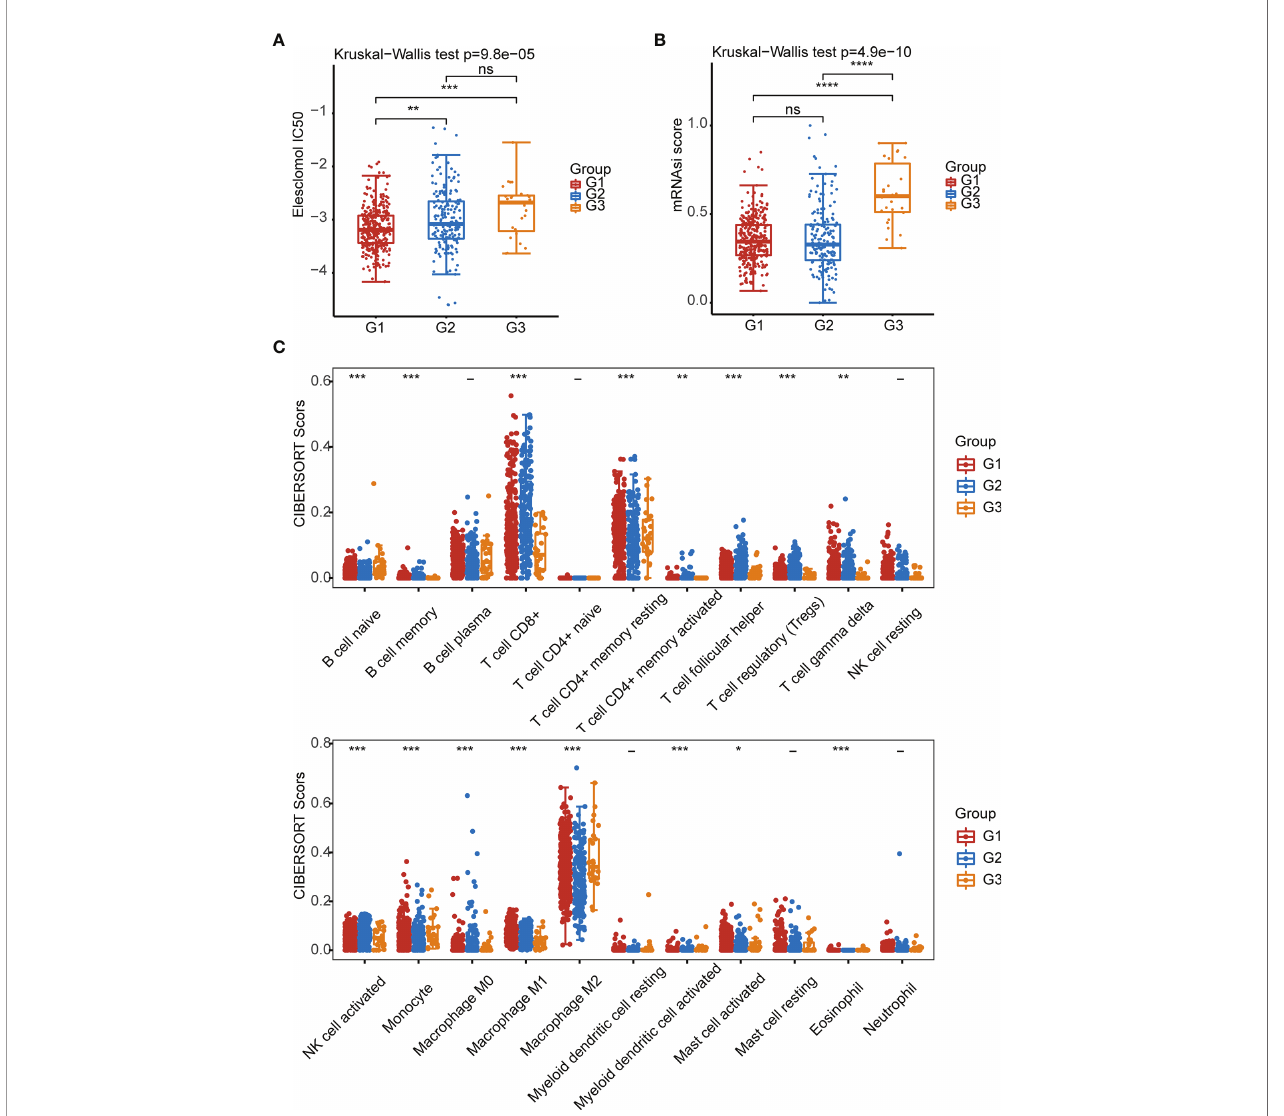
FIGURE 3 | Elesclomol sensitivity, tumor stemness and immune in fi ltration characteristics in the three subtypes of KIRC. (A) IC50 values of elesclomol. (B) Tumor stemness scores. (C) Abundances of 22 in fi ltrating immune cell types in the three subtypes. *p < 0.05, **p < 0.01, ***p < 0.001, ****p < 0.0001, ns, p >